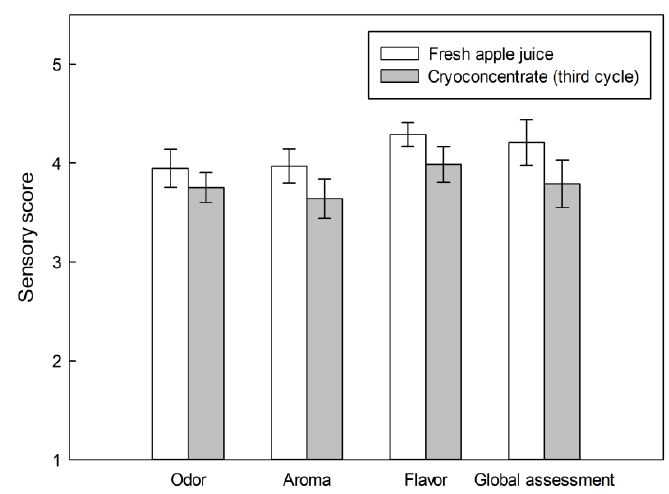
Figure 6. Sensory evaluation of fresh juice and cryoconcentrated sample (3rd cycle).